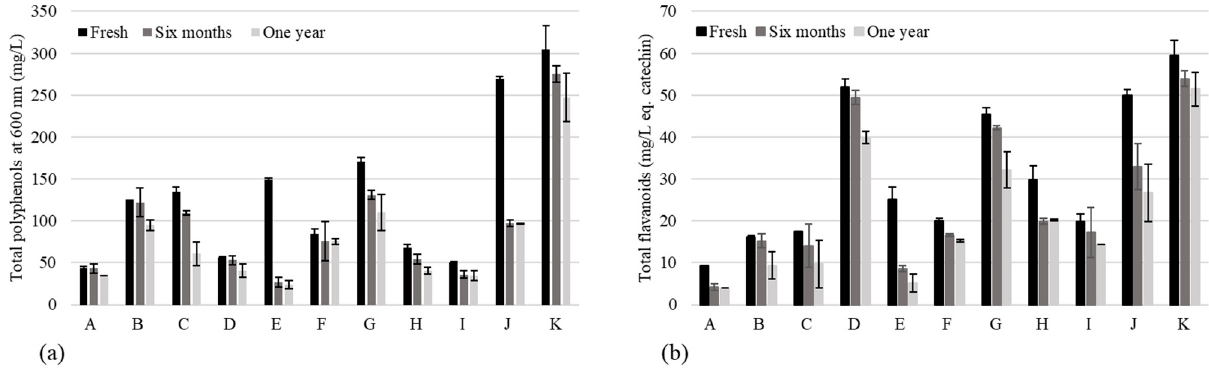
Figure 2. Evolution of total polyphenols (mg/L) ( a ) and total flavanoids (mg/L, eq. catechin) ( b ) of 11 commercial NABLABs through one year of storage at 20 °C in the dark.